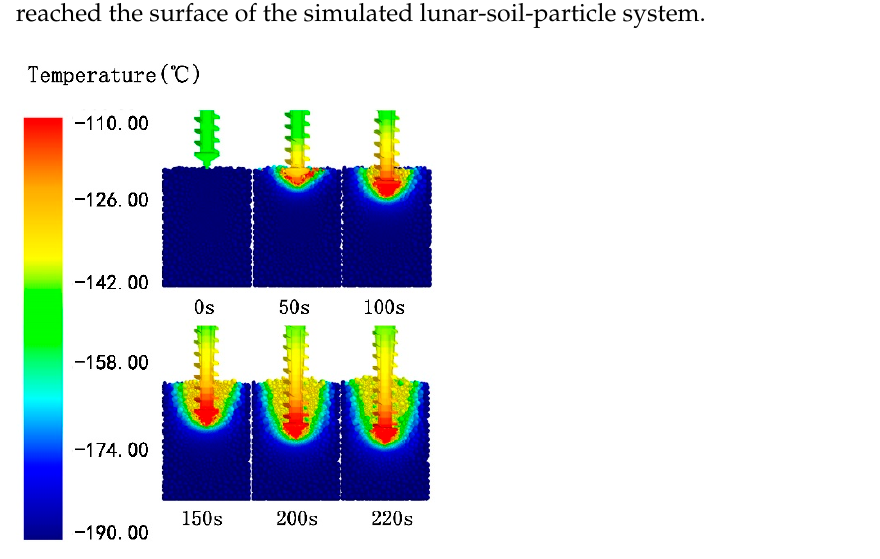
Figure 14. Velocity field of particles in No. A2 along Z -axis. 5. Conclusions 1.